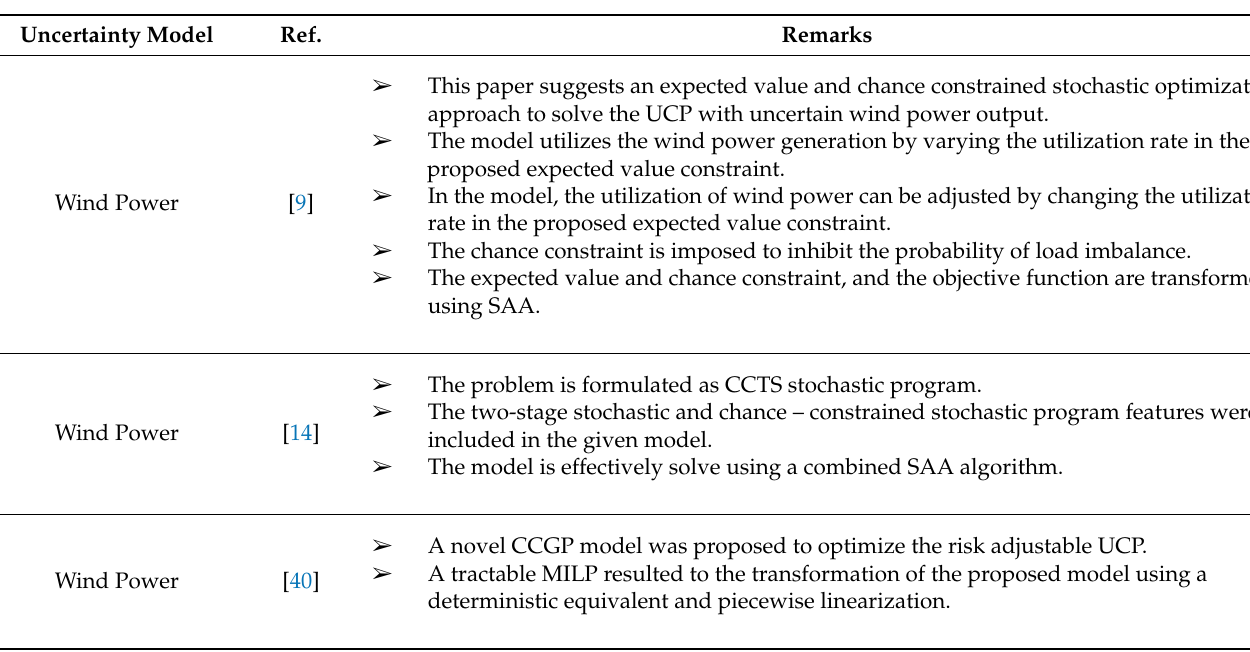
Table 12. Studies In Which CCP Is